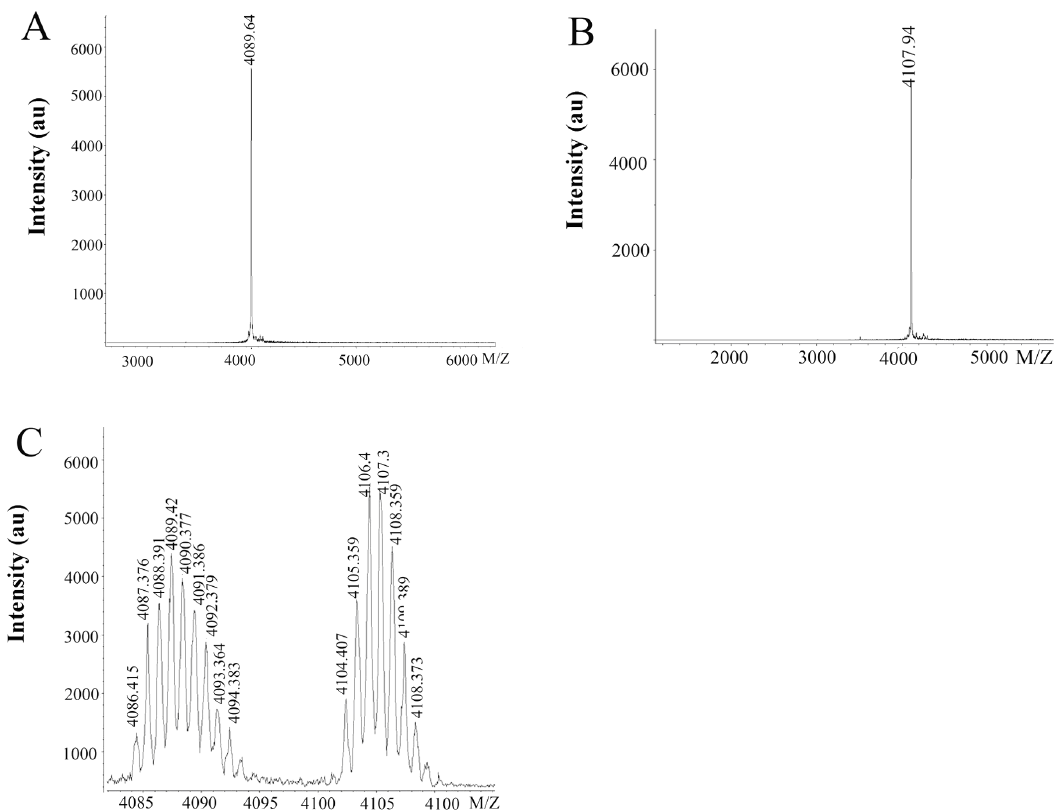
Figure 2. Mass spectrometry of mHWTX-IV and HWTX-IV. (A) Molecular mass of mHWTX-IV detected by mass spectrometry, 4089.64 Da. (B) Molecular mass of HWTX-IV, 4107.94 Da. (C) Monoisotopic mass spectrum of a mixture of mHWTX-IV and HWTX-IV.